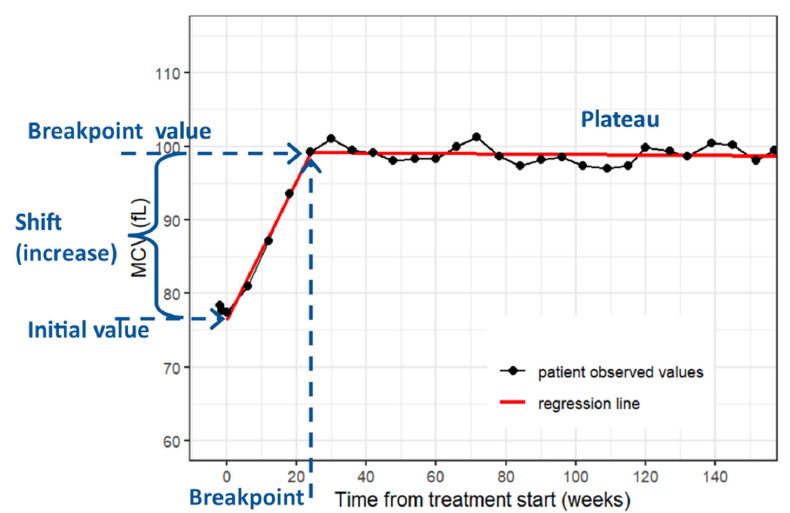
Figure 1. Illustration of statistical modeling of MCV time-courses and description of terminology.